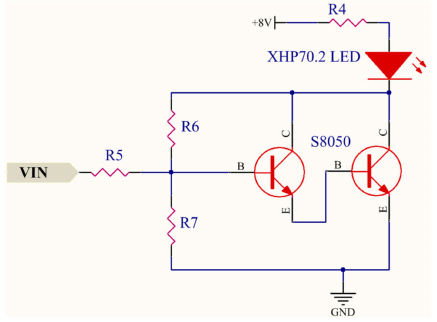
Figure 6. Schematic design of the LED